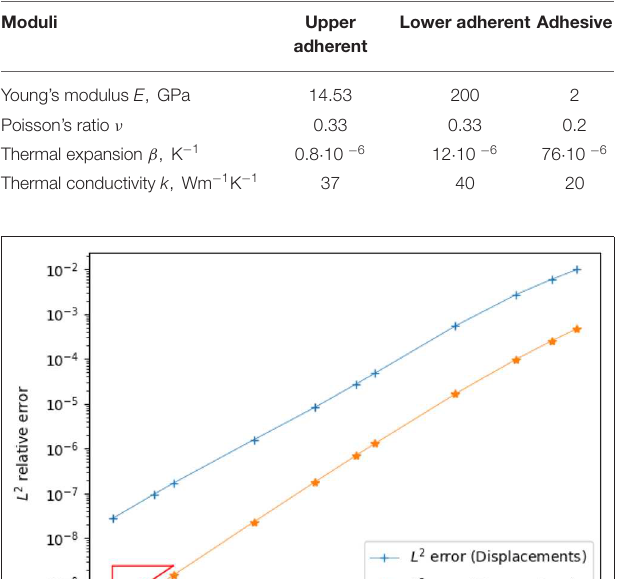
Frontiers in Materials |